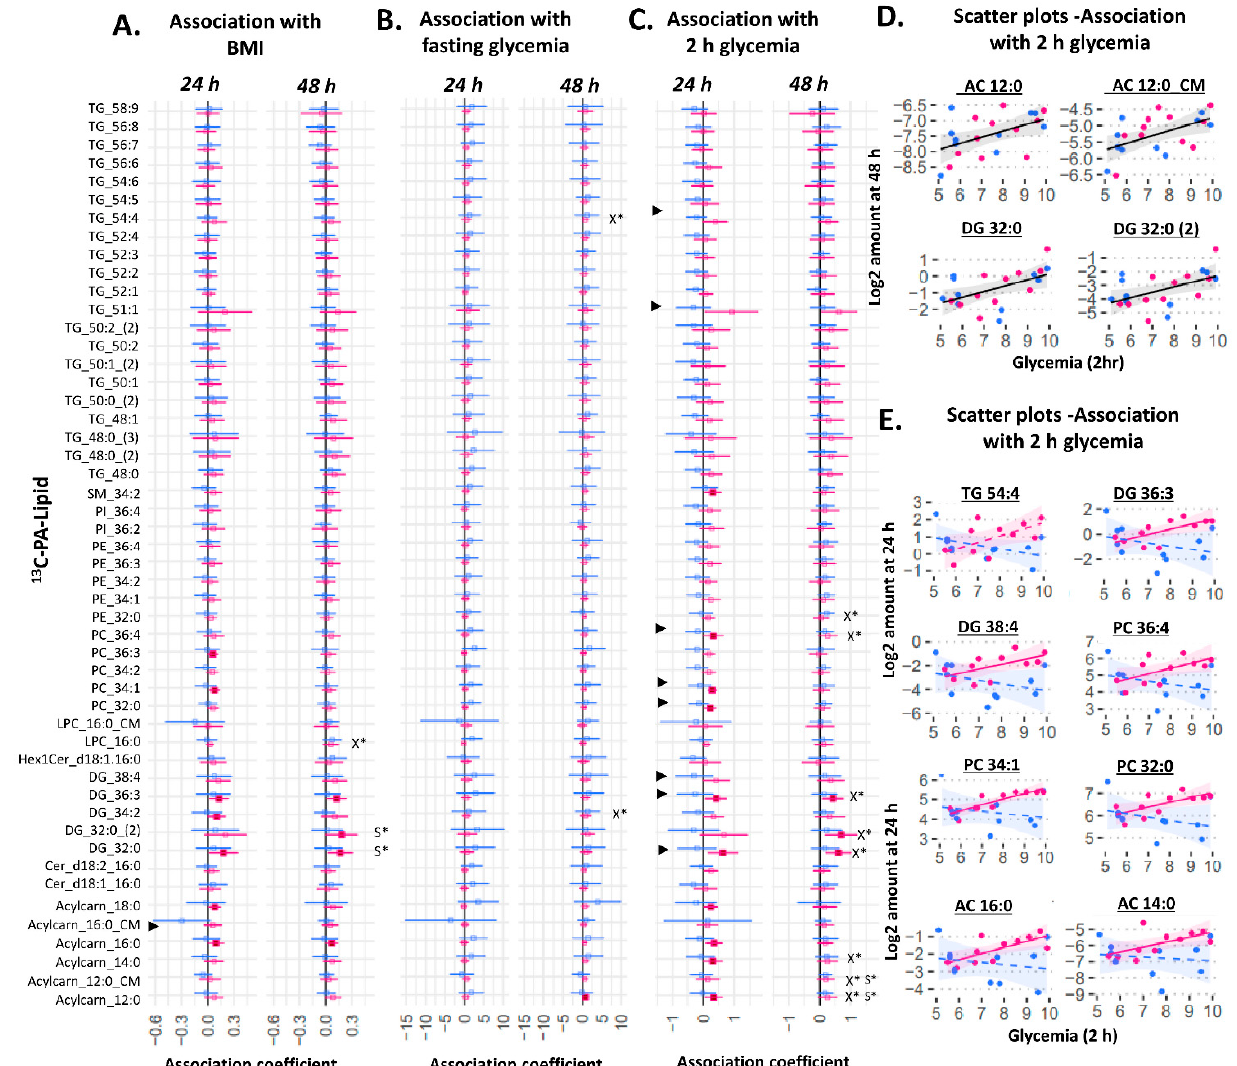
Figure 4. Sex-stratified associations between the amount of 13 C-PA lipid (outcome) and maternal glycemia or maternal BMI (predictor). X* represents p < 0.05 in linear regression with males and females combined (not shown). S* represents p < 0.05 in linear regression adjusted for sex (not shown). ► represents significant p < 0.05 for the interaction between sex and maternal glycemia on amount of lipid. Linear regression was then run separately for males and females. Forest plots ( A – C ) show association coefficient and 95% confidence intervals for males (blue) and females (red) with significance ( p < 0.05) shown by dark-colored filled squares. Unadjusted scatter plots illustrating the relationship between 2 h glycemia and amount of lipid for ( D ) lipids where males and females show similar relationships and for ( E ) lipids where males and females show different relationships. The Benjamini–Hochberg method was used to correct for multiple testing. Abbrevia-